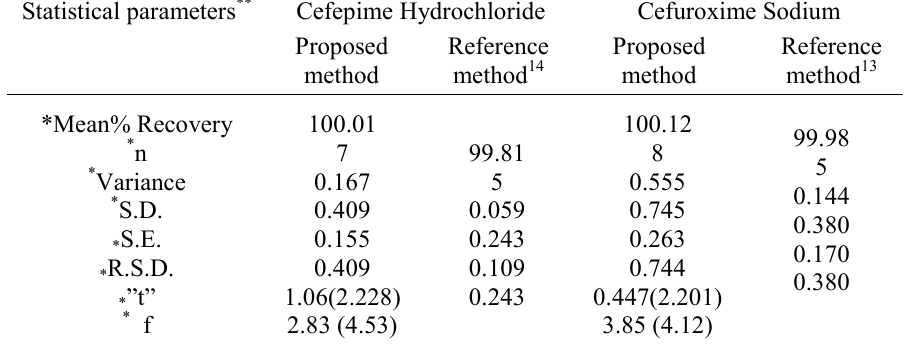
Table 3. Comparative analytical results of the proposed and the reported methods for the tested drugs in pure forms: